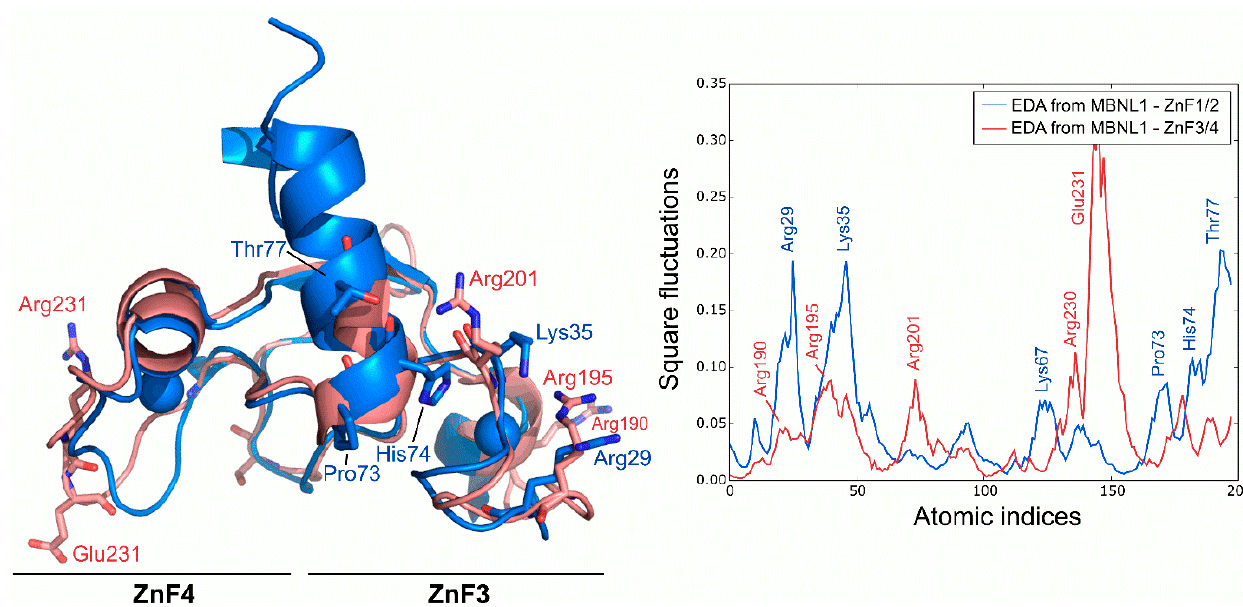
Figure 4. Global fluctuations of MBNL1, ZnF1/2, and ZnF3/4 computed from their backbone heavy atoms. Atomic indices correspond to residues 24 to 75 for ZnF1/2 (blue structure) and 185 to 236 for ZnF3/4 (red structure).